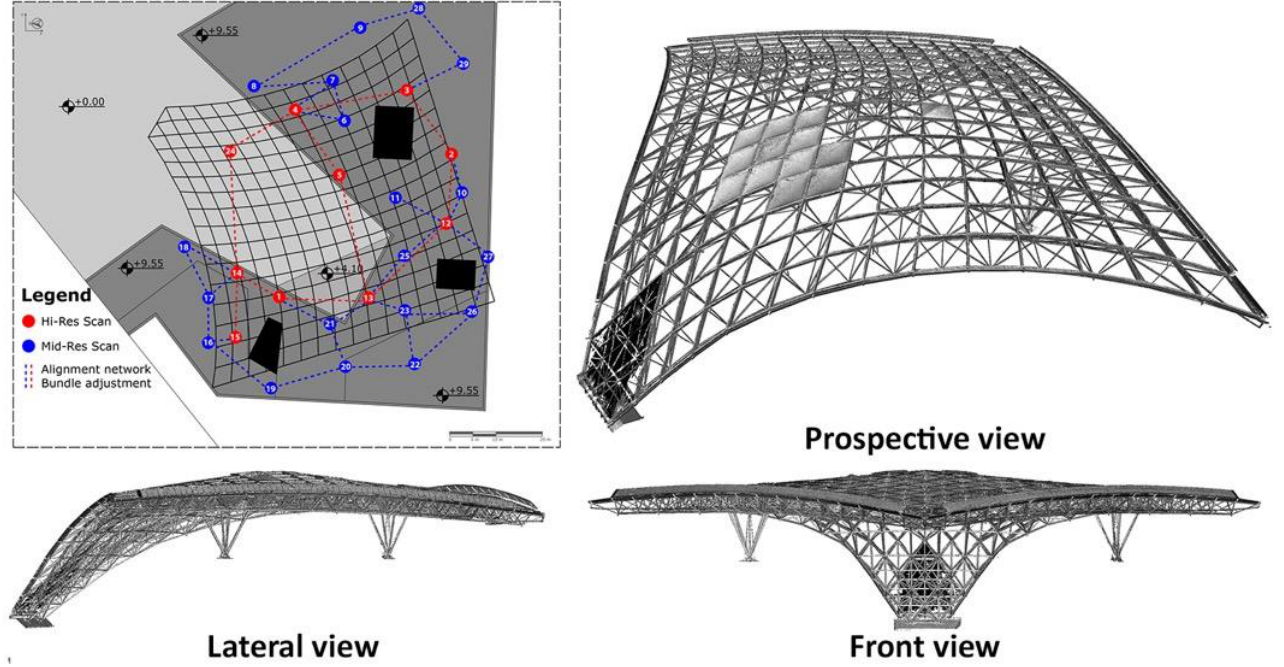
Figure 6. Distribution schema of 3D scanning stations and full range-based point cloud.